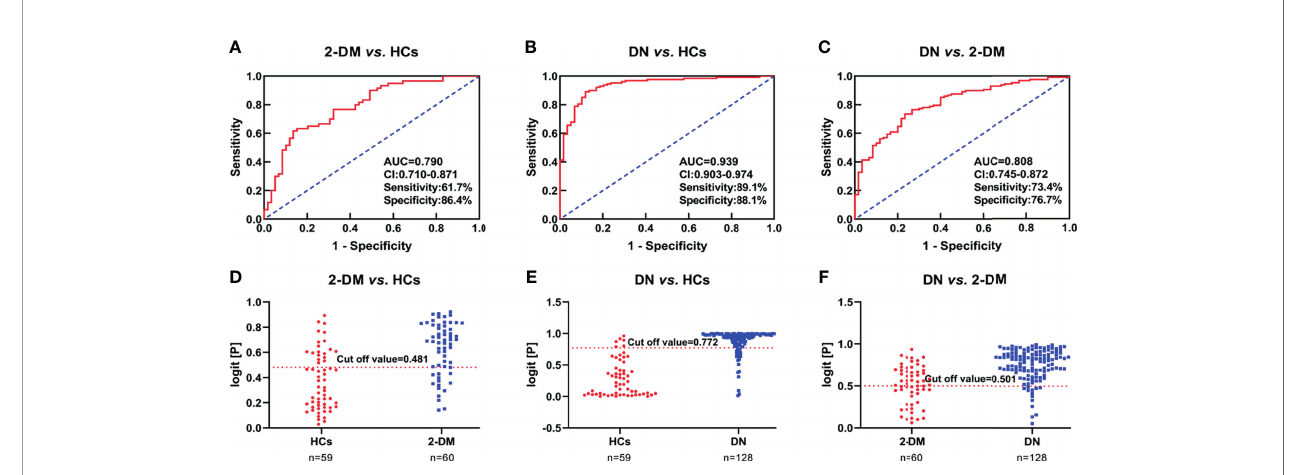
FIGURE 3 | (A – C) Receiver operating characteristic curve analysis (ROC) in combination with LPE(16:0) and TAG54:2-FA18:1 to discriminate HCs, 2-DM and DN patients in the Validation Set. (D – F) Prediction accuracies of the panel of biomarkers (LPE(16:0) and TAG54:2-FA18:1) in the Validation Set. The area under the curve (AUC) is given at 95 % con fi dence intervals. AUC, area under the curve; CI, con fi dence